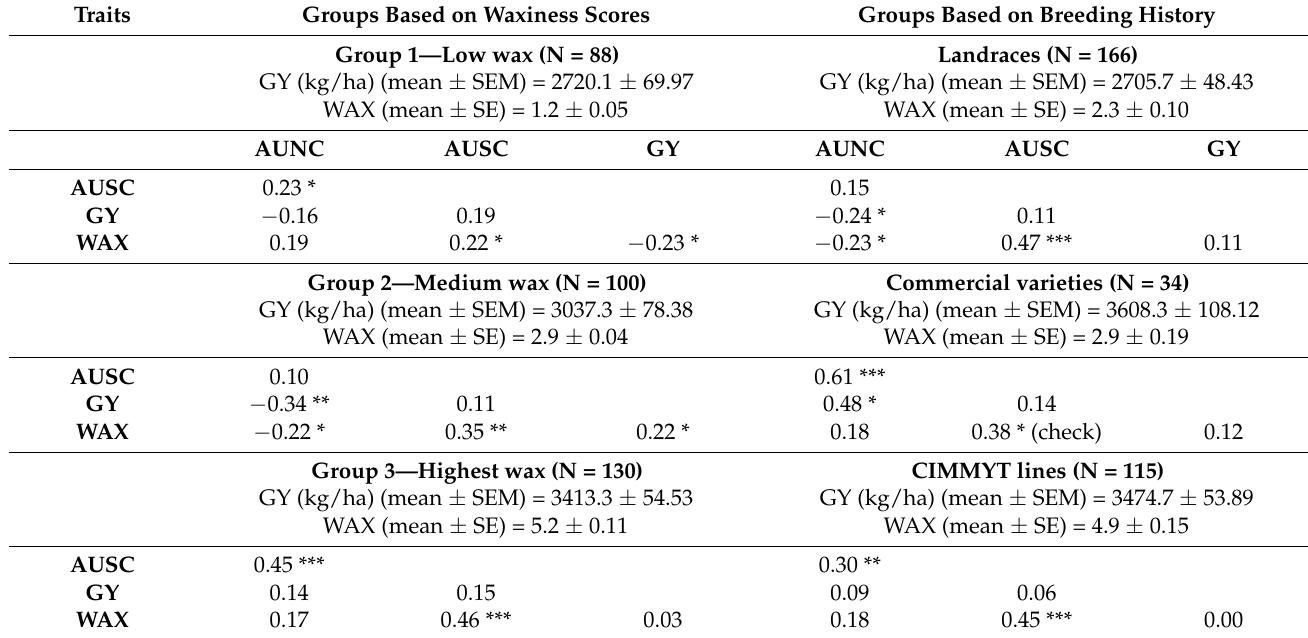
Table 2. Pearson correlations between pairs of phenotypic traits evaluated in field experiments conducted at the Elora Research Station (Canada) in 2016 (a dry year), after segregating the data based on waxiness scores and breeding histories. Traits